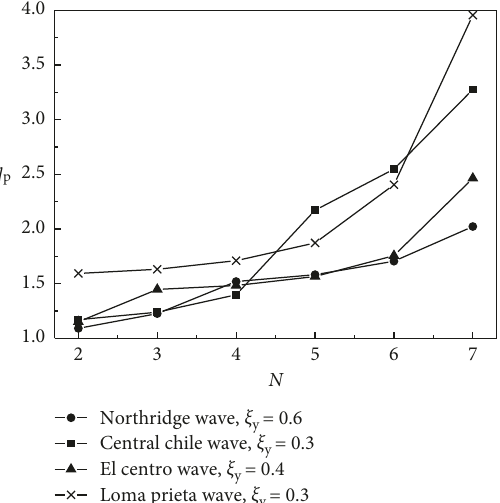
Figure 13: Influence of storey number N